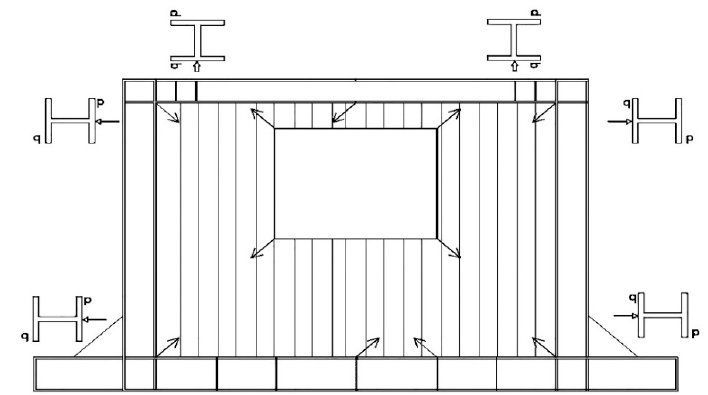
Figure 8. Location of strain gauges used during the test of specimen 1.